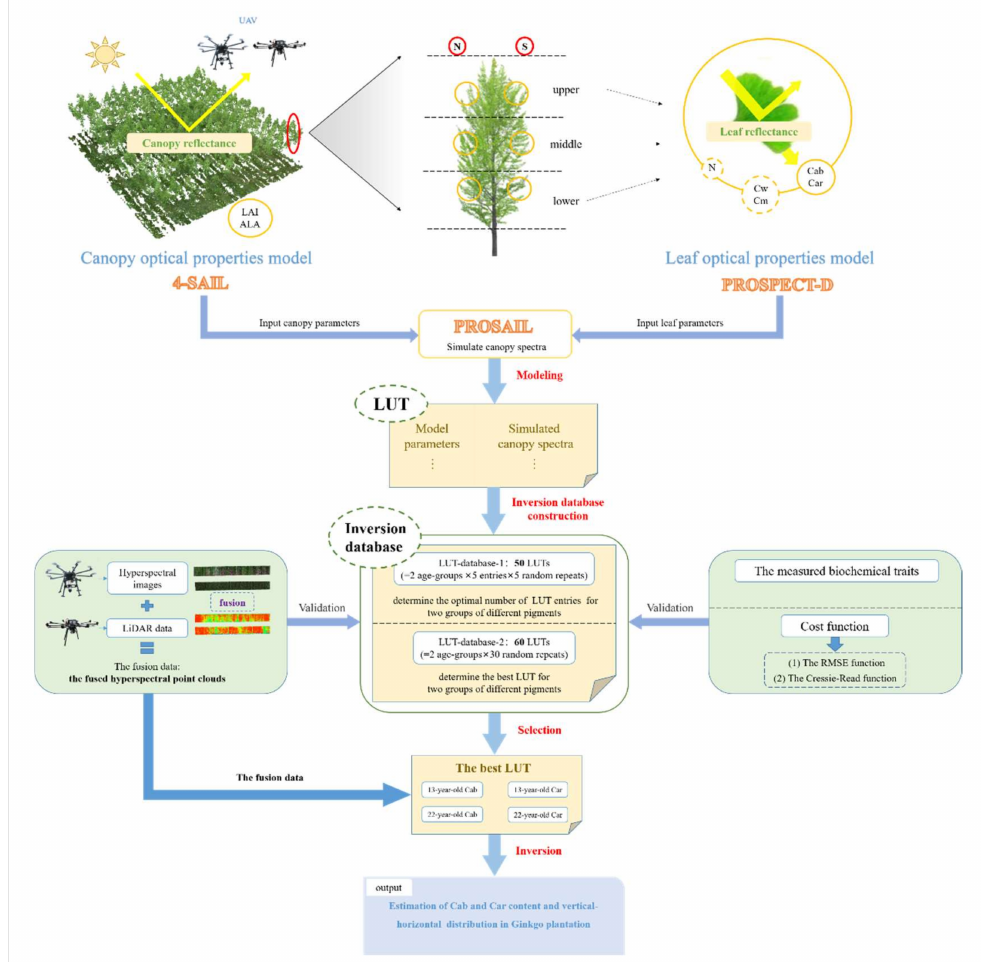
Figure 2. An overview of the analysis workflow for assessing the content of ginkgo pigments . Note: “N, S” represent the north and south orientation; “upper, middle, lower” represent the upper, the middle, and the lower vertical layer; “2 age-groups” represent age 13-year-old and age 22-year-old; “5 entries” represent the number of LUT entries, varying from 1000 to 16,000 with the step of multiplying as 2 (i.e., 1000, 2000, 4000, 8000, 16,000); “5 random repeats” represent running random parameter sampling 5 times; “30 random repeats” represent running random parameter sampling 30 time; Cab = Chlorophyll; Car = Carotenoid; LAI = Leaf area index; ALA = Average leaf angle; N = Structural coefficient; Cw = Water content; Cm = Dry matter